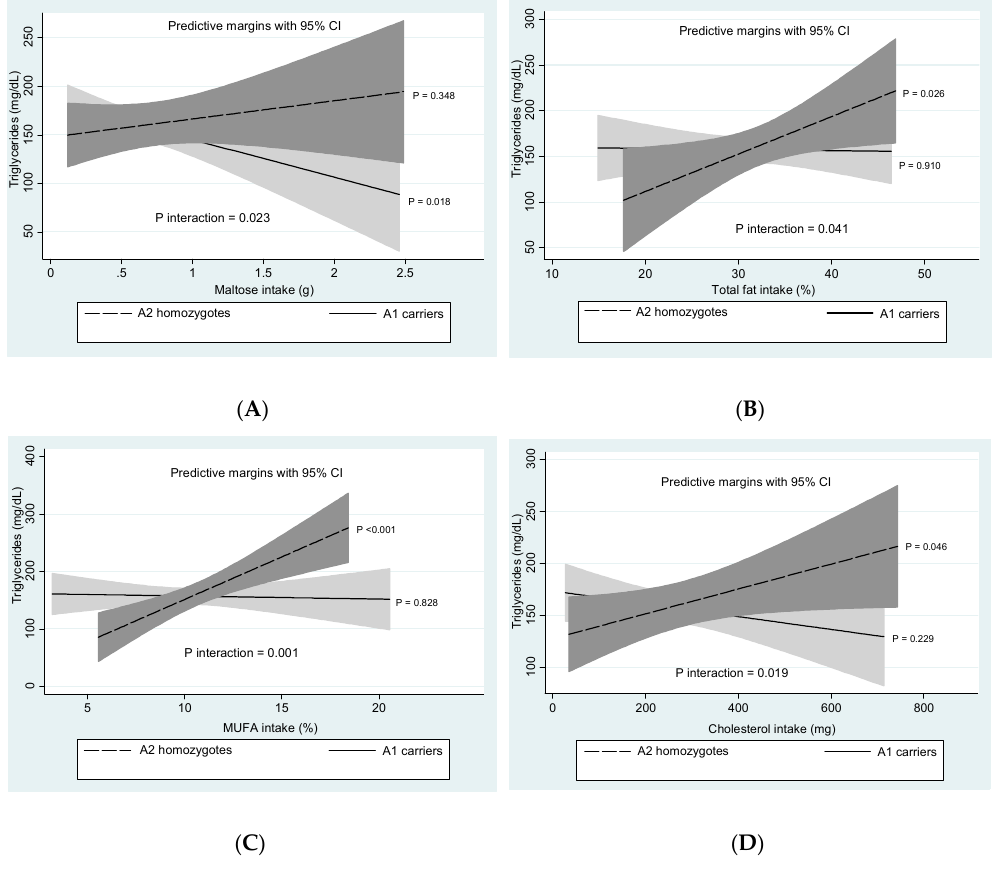
Figure 1. DRD2/ANKK1 -diet interactions with reference to blood triglyceride levels. ( A ) Figure 1. DRD2 / ANKK1 -diet interactions with reference to blood triglyceride levels. DRD2/ANKK1 -maltose intake interaction. ( B ) DRD2/ANKK1 -fat intake interaction. ( C ) DRD2/ANKK1 - ( A ) DRD2 / ANKK1 -maltose intake interaction. ( B ) DRD2 / ANKK1 -fat intake interaction. MUFA intake interaction. ( D ) DRD2/ANKK1 -cholesterol intake interaction. MUFA: Monounsaturated ( C ) DRD2 / ANKK1 -MUFA intake interaction. ( D ) DRD2 / ANKK1 -cholesterol intake interaction. fatty acids. MUFA: Monounsaturated fatty